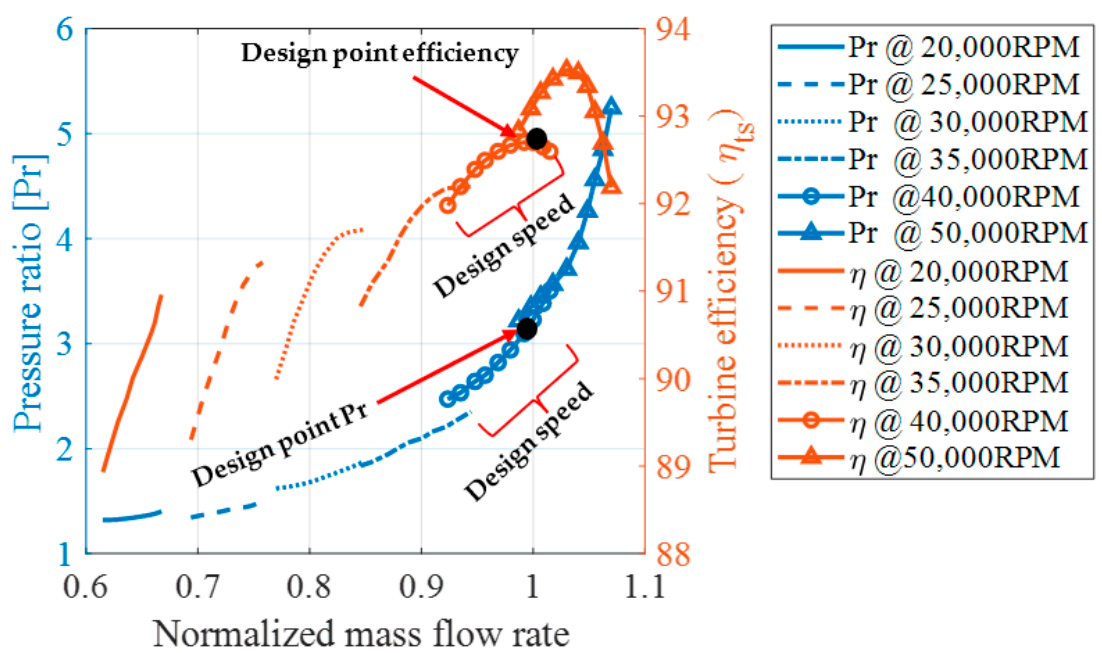
Figure 17. Off-design performance of the optimized turbine geometry.